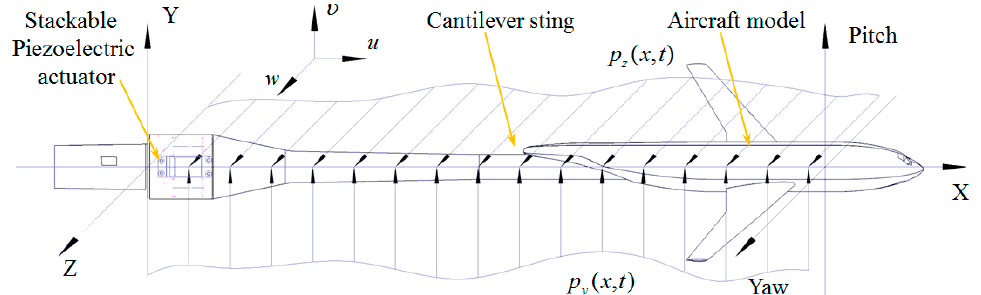
Figure 2. Schematic diagram of cantilever sting with stackable piezoelectric actuators.